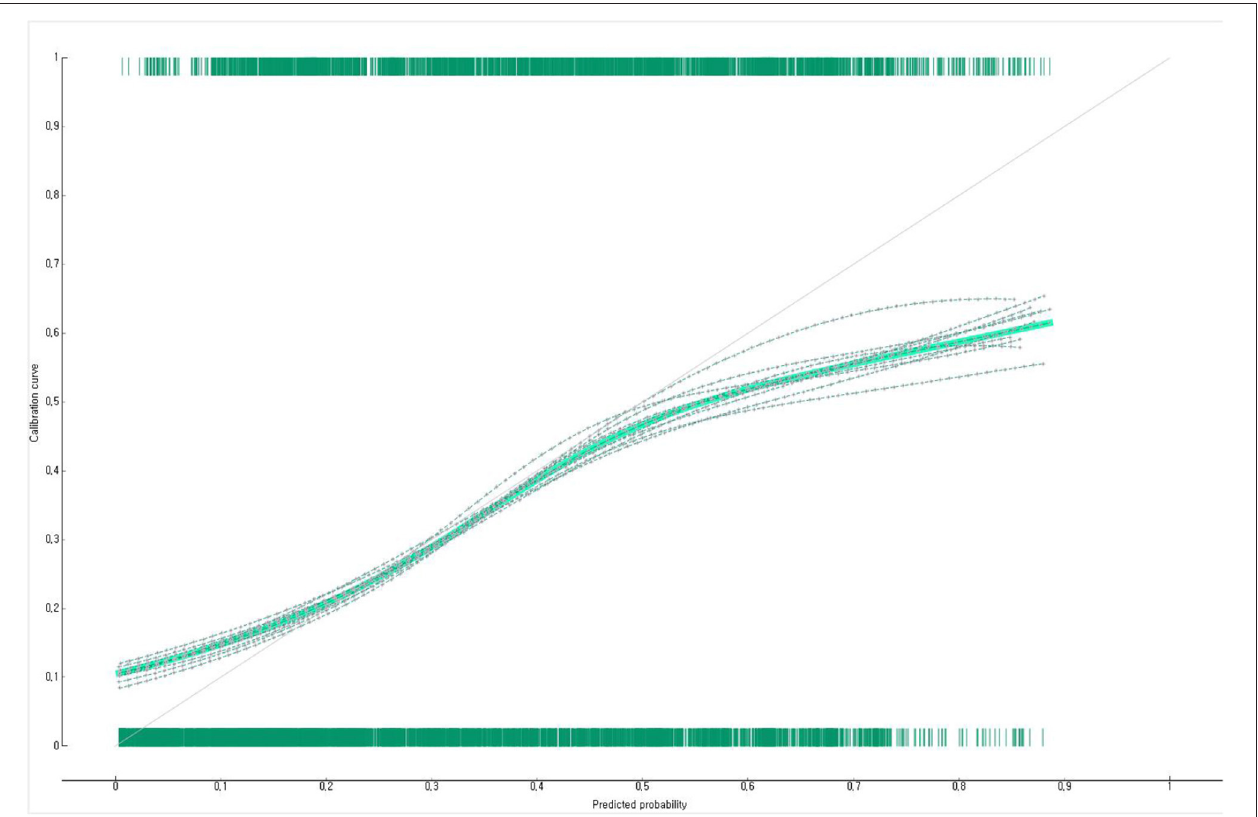
FIGURE 11 | Calibration plot of the Bayesian nomogram for predicting the depressive disorders of female older adults living